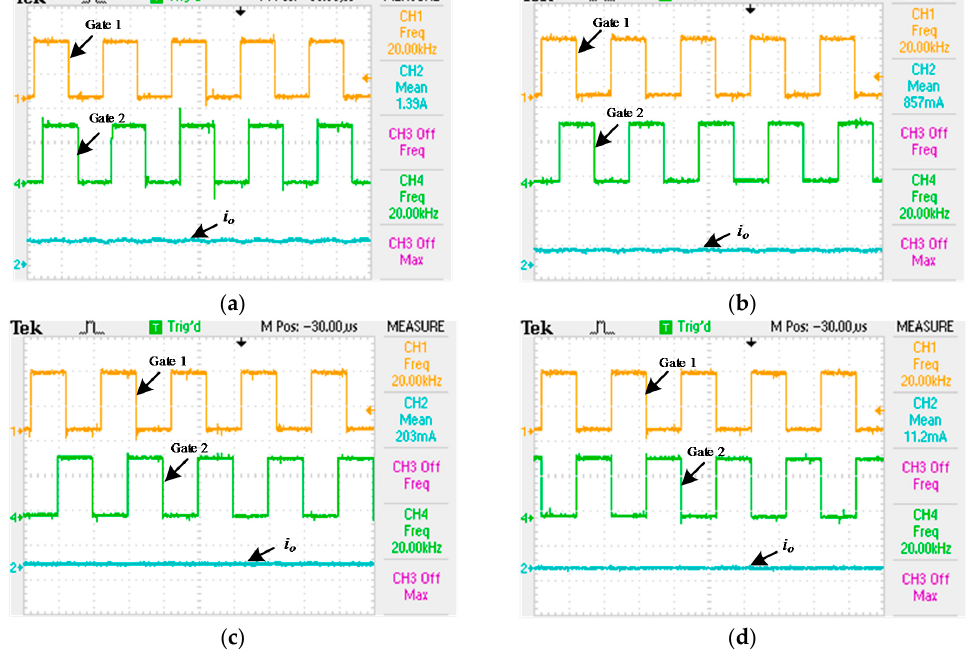
Figure 14. Experimental verification of power modulation: ( a ) 45 degrees phase difference; ( b ) 90 degrees phase difference; ( c ) 135 degrees phase difference; ( d ) 180 degrees phase difference.